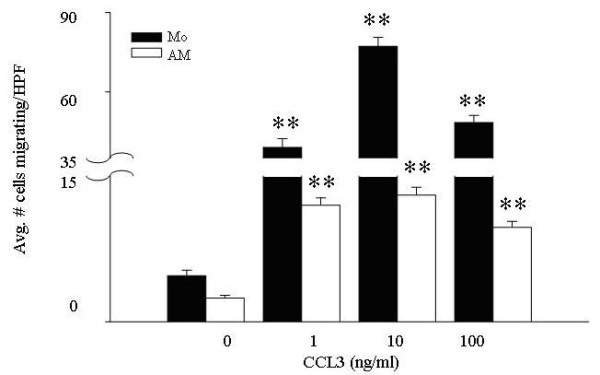
CCL3 is a chemoattractant for both peripheral blood monocytes and alveolar macrophages. Freshly isolated monocytes and alveolar macrophages (4.5 × 104 per condition) were subjected to migration assays using increasing concentrations of rhCCL3 as the chemoattractant. Monocytes (filled bars) and alveolar macrophages (open bars) responded in a dose-dependent manner to CCL3 (1–100 ng/ml). Compared to unstimulated cells, cellular migration was significant (**p < 0.001) at all CCL3 concentrations tested, for both cell types. Additionally, the average number of migrating alveolar macrophages (maximal response = 13.0 ± 0.8 migrating cells per high-powered field at 10 ng/ml CCL3) was 4–6-fold less than the average number of migrating monocytes (maximal response = 77.2 ± 3.4 migrating cells per high-powered field, at 10 ng/ml CCL3) (p < 0.001 when comparing monocyte and alveolar macrophage migration at every concentrations of CCL3). The mean of six independent experiments ± SEM are shown.